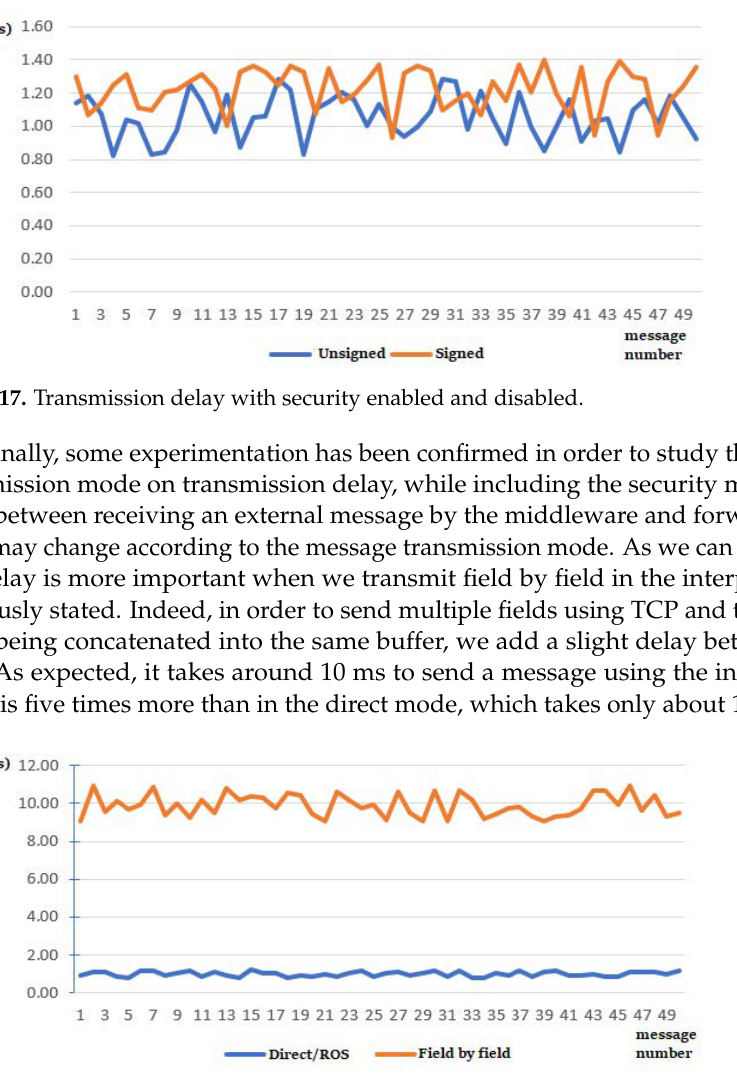
Figure 18. Transmission delays according to the transmission mode.